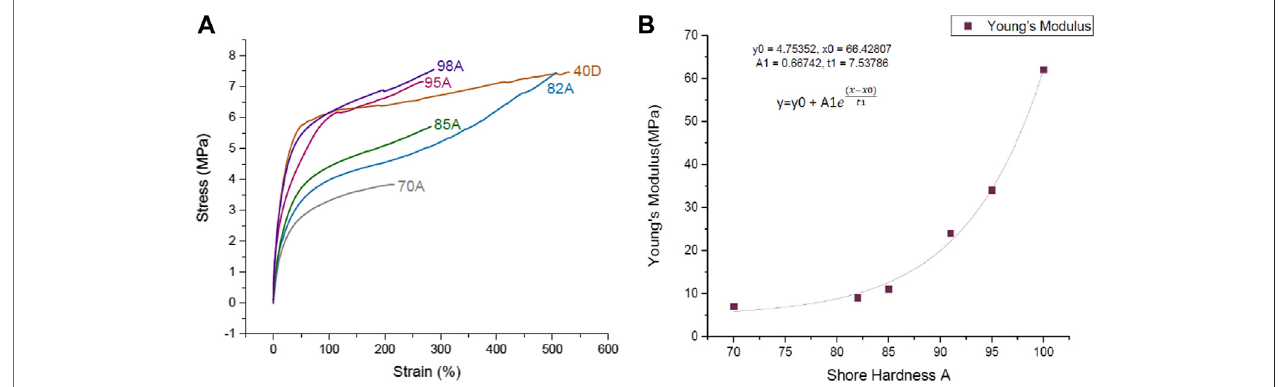
FIGURE 2 | (A) Stress – strain curve up to the point of fracture for the 3D-printed TPU strips with in situ integrated sensing elements using TPU fi laments with different Shore hardnesses. (FilaFlex 70A, 82A, 95A, and 40D; NinjaFlex 85A; Yousu 98A). (B) Correlation of the Young ’ s modulus and the Shore hardness of the 3D- printed TPU strips without the strain sensing element. The plot was fi tted as a one-phase exponential growth with time offset.